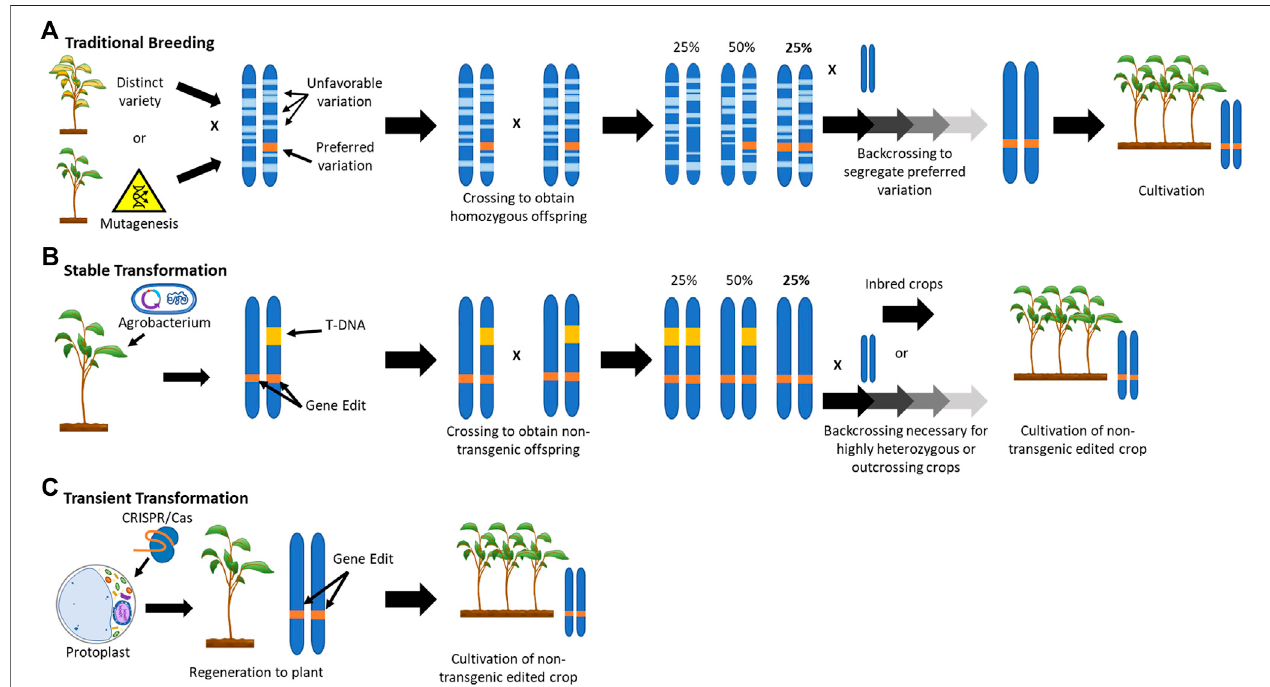
FIGURE 1 | Schematic Representation of the Application of New Plant Breeding